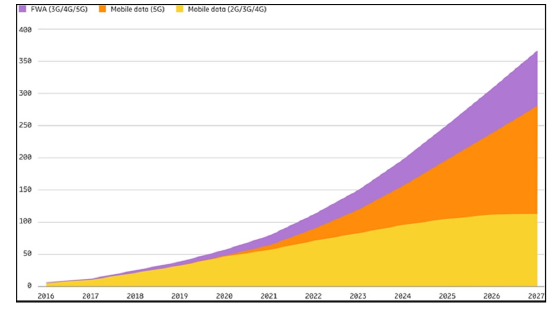
Figure 1. Global mobile data traffic of the